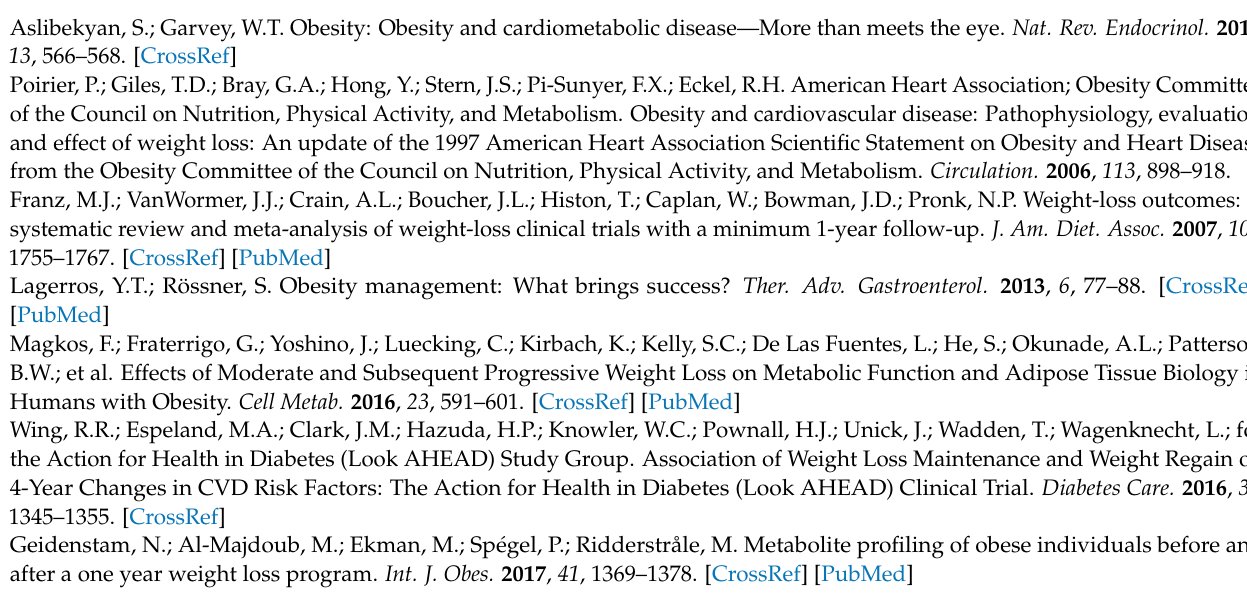
S1: Flow chart of study participants, Table S1: List of metabolites identified, Table S2: Baseline characteristics of 236 participants initially recruited in the SATIN study and 162 participants included in the present analyses, Table S3: Significant changes in concentrations of metabolites after ≥ 8% weight loss, Table S4: Changes in cardiometabolic parameters at 8 weeks of a low-calorie diet (LCD) per 1SD log-transformed changes in the concentrations of metabolites in a sensitivity analysis with adjustment for changes in energy intake and physical activity, Table S5: Significant changes in concentrations of metabolites after weight loss